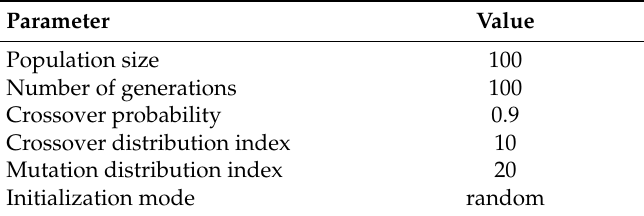
Table 3. Parameter settings for NSGA-II.